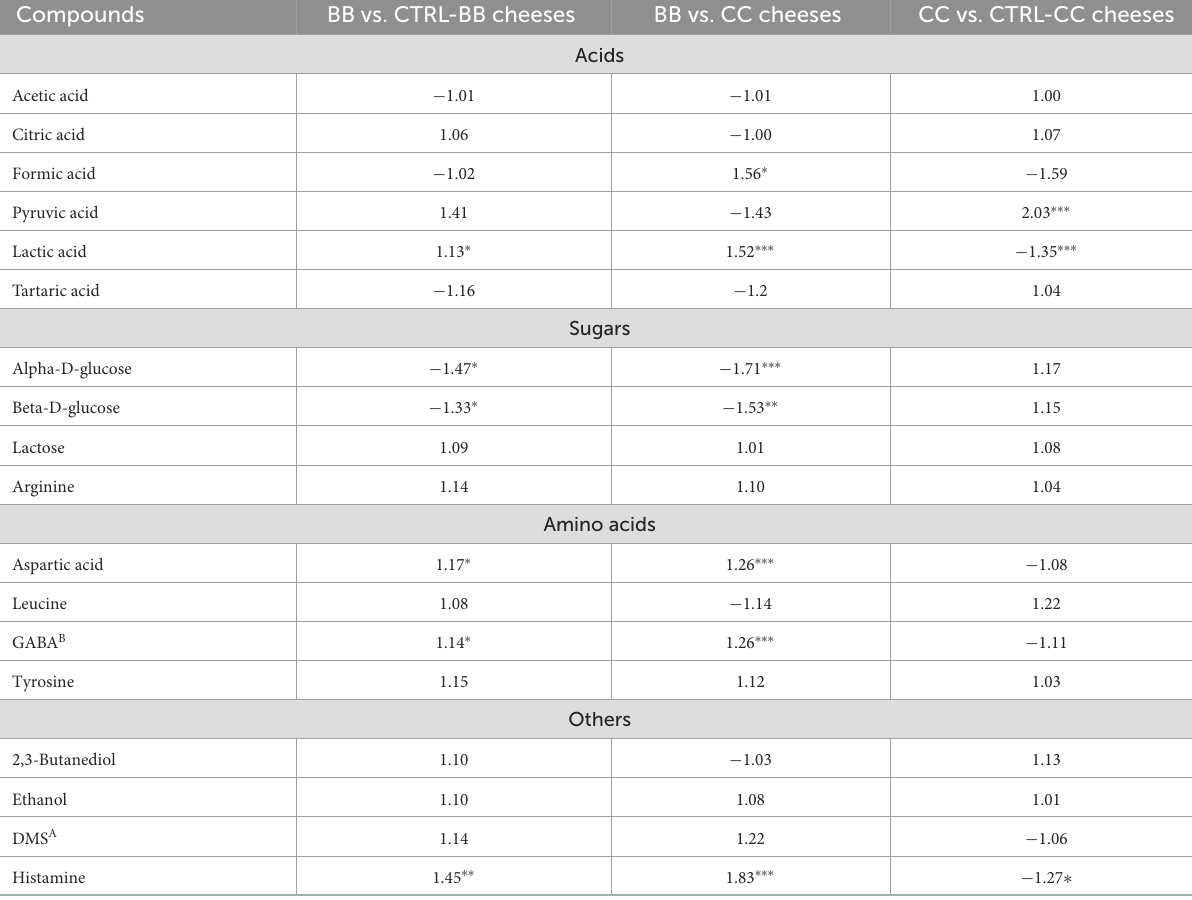
TABLE 3 Identified compounds in CTRL and cheeses enriched with 0.6% of BB and CC by NMR analysis. Compounds BB vs. CTRL-BB cheeses BB vs. CC cheeses CC vs. CTRL-CC cheeses